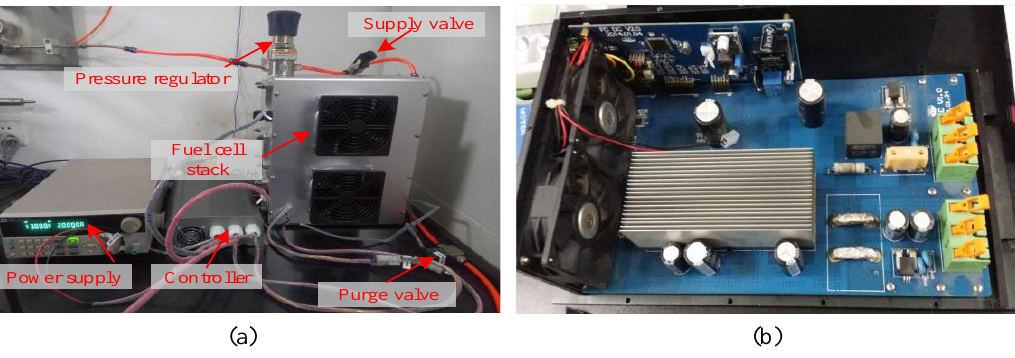
Figure 3. Proton exchange membrane fuel cell (PEMFC) generation system. ( a ) The fuel cell stack and its auxiliary; ( b ) the fuel cell’s DC/DC converter.